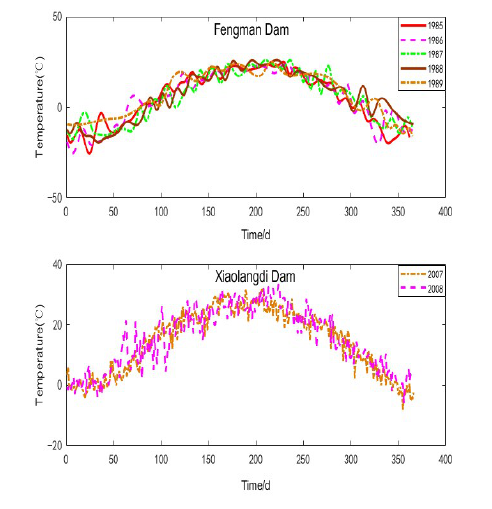
Figure.5 Temperature change at the dam site of two the